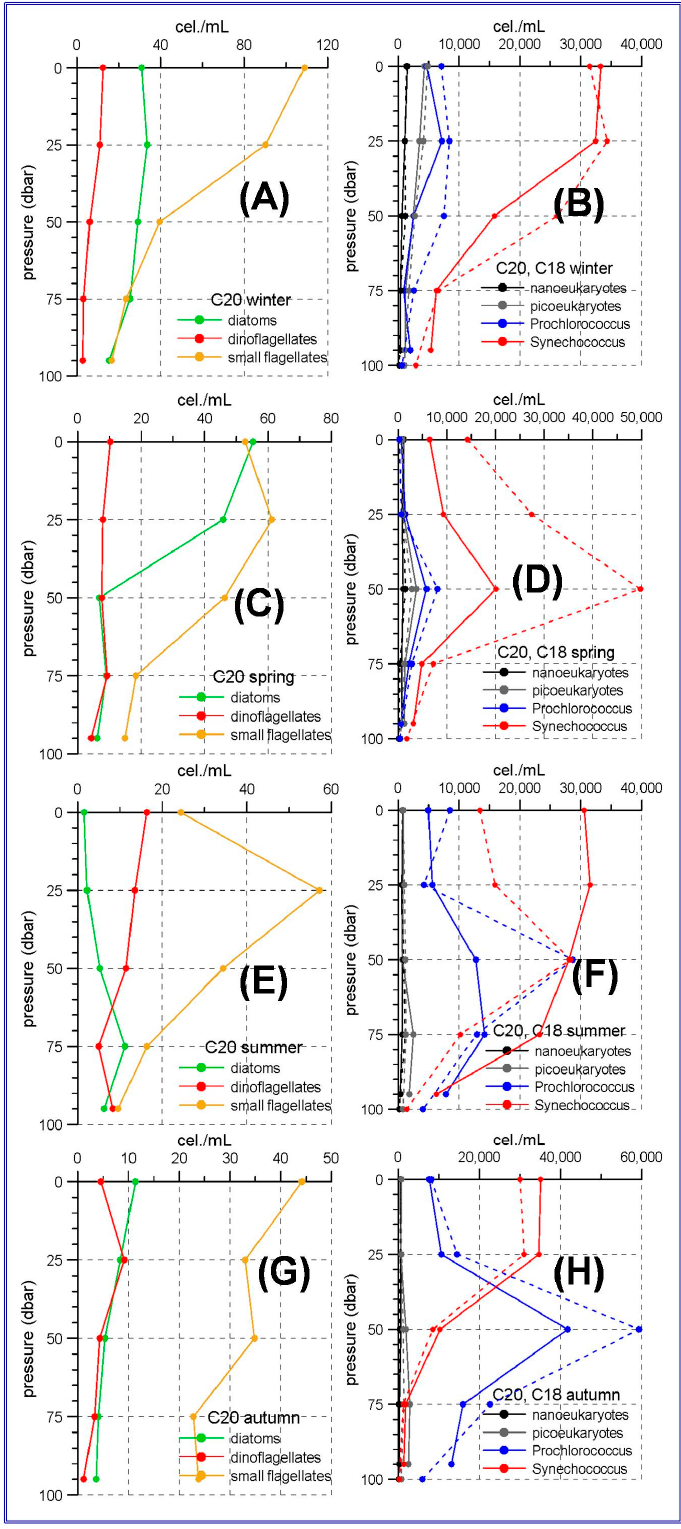
Figure 3. ( A ) shows the winter average vertical distribution of diatom abundances (green line), small flagellates (yellow line) and dinoflagellates (red line) at station C20. ( B ) shows the winter average vertical distribution for nanoeukaryotes (black line), picoeukaryotes (grey line), Prochlorococcus (blue line) and Synechococcus (red line) at the stations C20 (solid line) and C18 (dashed line). ( C , D ) are the same for spring, ( E , F ) for summer and ( G , H ) for autumn.